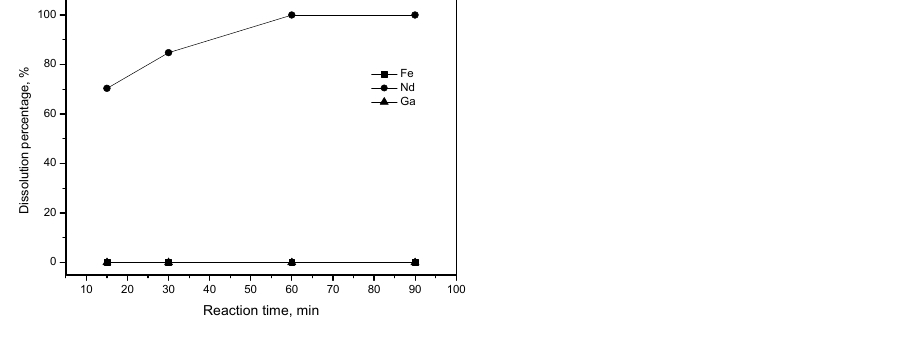
Figure 6. Effect of time on the leaching of oxide mixtures by 0.05 M H 2 SO 4 in EG. Operation condi- tions: pulp density = 50 g/L, T = 25 °C, stirring speed = 400 rpm. conditions: pulp density = 50 g/L, T = 25 ◦ C, stirring speed = 400 rpm.